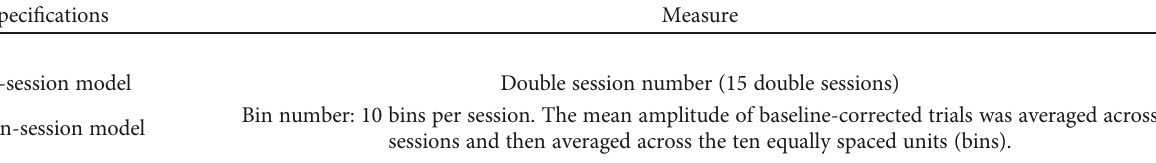
Table 2: E ff ects considered for statistical